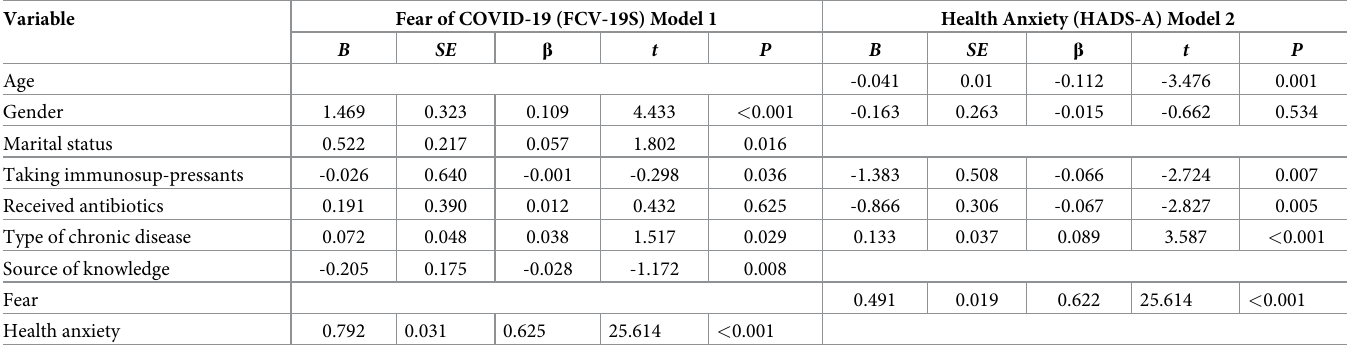
Table 3. Predictors of fear and health anxiety regarding COVID-19 in multiple linear regression analysis.